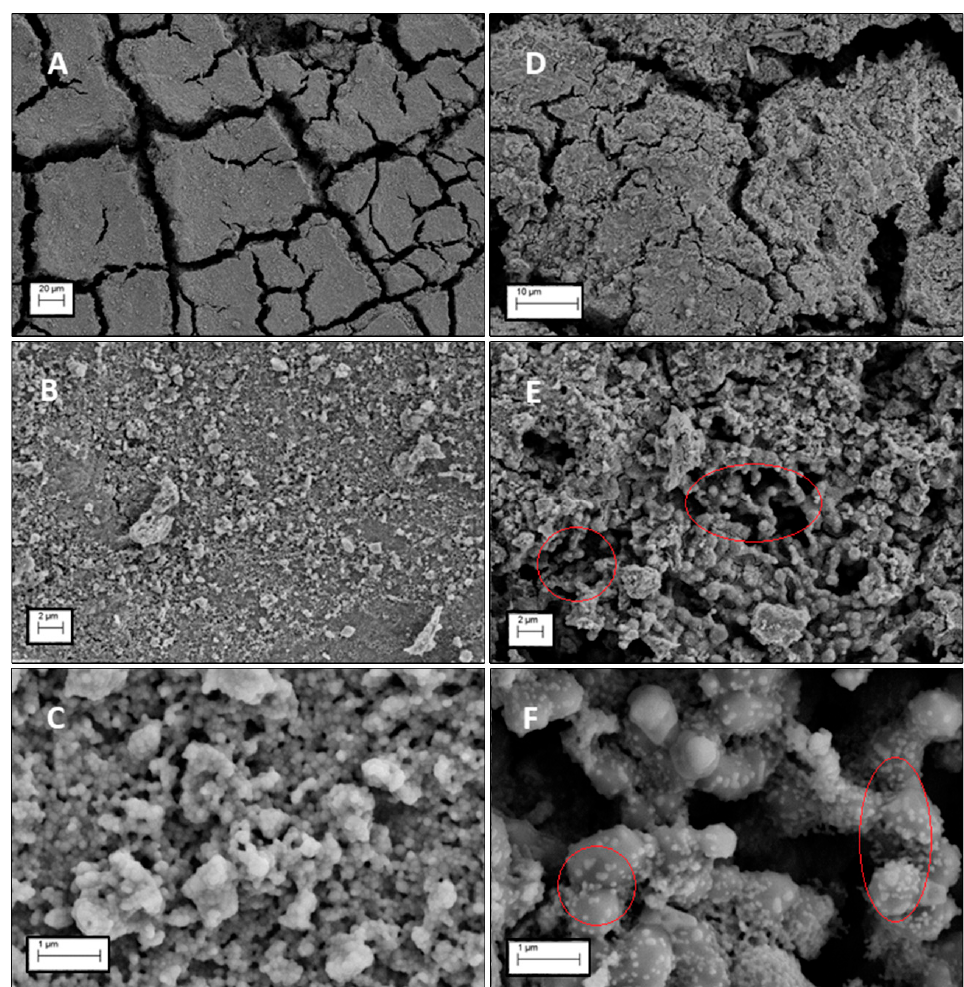
Figure 5. Top-view micrographs (fully completed infiltration) of the LSCM / GDCW cathode at di ff erent magnifications: external layer ( A – D ) and internal electrode ( E , F ). Subfigures from ( A – D ) have been taken on the outer surface, while subfigures ( E , F ) have been taken inside the crevices clearly visible in ( A , D ). Doped-ceria nanoparticles (in red circles) are poorly accessible, as they can only be observed considerably deep inside the electrode.